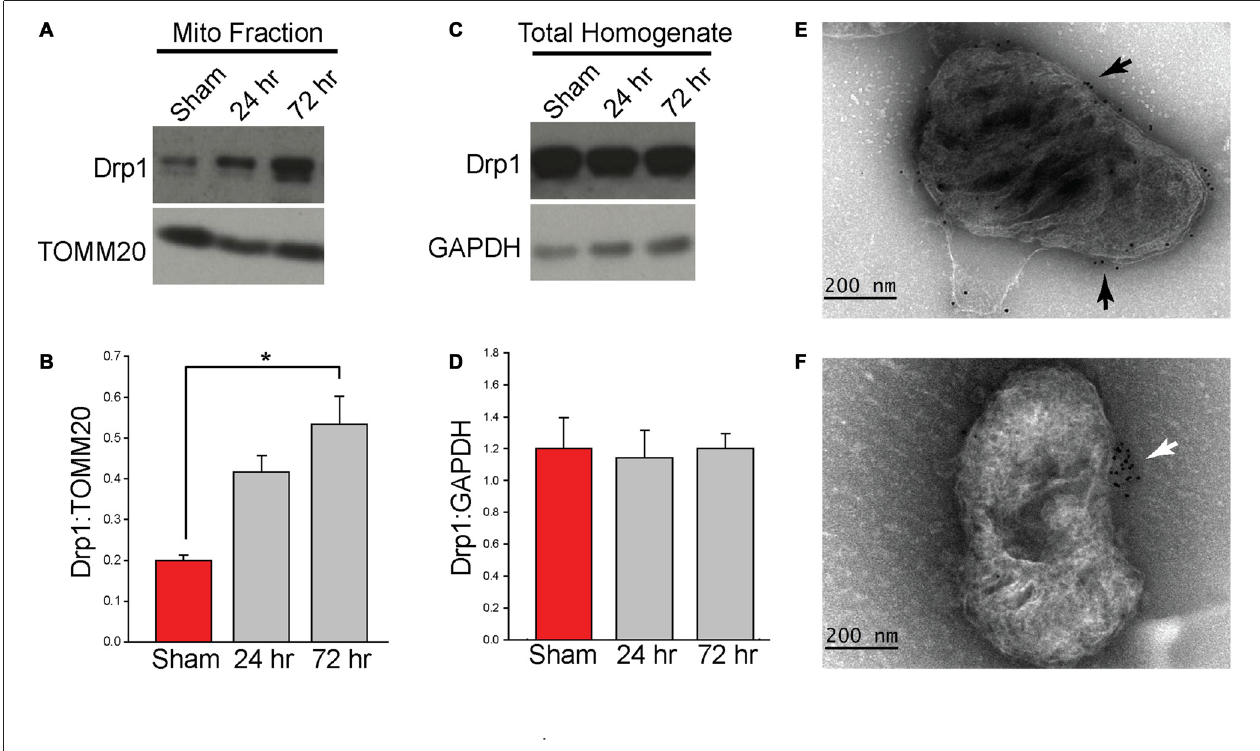
FIGURE 2 | Controlled cortical impact (CCI) injury increases the level of Drp1 in isolated hippocampal mitochondrial fractions. Animals were injured by CCI and mitochondria were isolated from injured hippocampal tissues at 24 h and 72 h post-injury. (A) Representative western blots of isolated ipsilateral hippocampal mitochondrial fractions from sham and injured (24 and 72 h) animals. (B) Relative immunoreactivity of each band was quantified and Drp1 optical density values were normalized to TOMM20. Drp1 levels increase marginally at 24 h and significantly at 72 h ( p = 0.007) post-injury. (C) Representative western blots from ipsilateral hippocampal homogenate from sham and injured (24 and 72 h) animals. (D) Immunoreactivity was quantified and optical density values for Drp1 were normalized to GAPDH. Results indicate no Drp1 level changes in the ipsilateral hippocampus. Immuno-gold labeling was also performed using a primary antibody for TOMM20, a mitochondrial outer membrane (MOM) translocase, and Drp1 with a gold-conjugated secondary antibody. (E) Representative image of TOMM20 immuno-gold labeling on the MOM. Gold particles indicated by black arrows. (F) Representative image of Drp1 immuno-gold labeling on a mitochondrion from the injured hippocampus. Gold labeling for Drp1 was found to be associated with the isolated mitochondria and associated with the MOM (indicated by white arrow). Data are presented as the mean ± standard error of the mean (SEM). ∗ p <